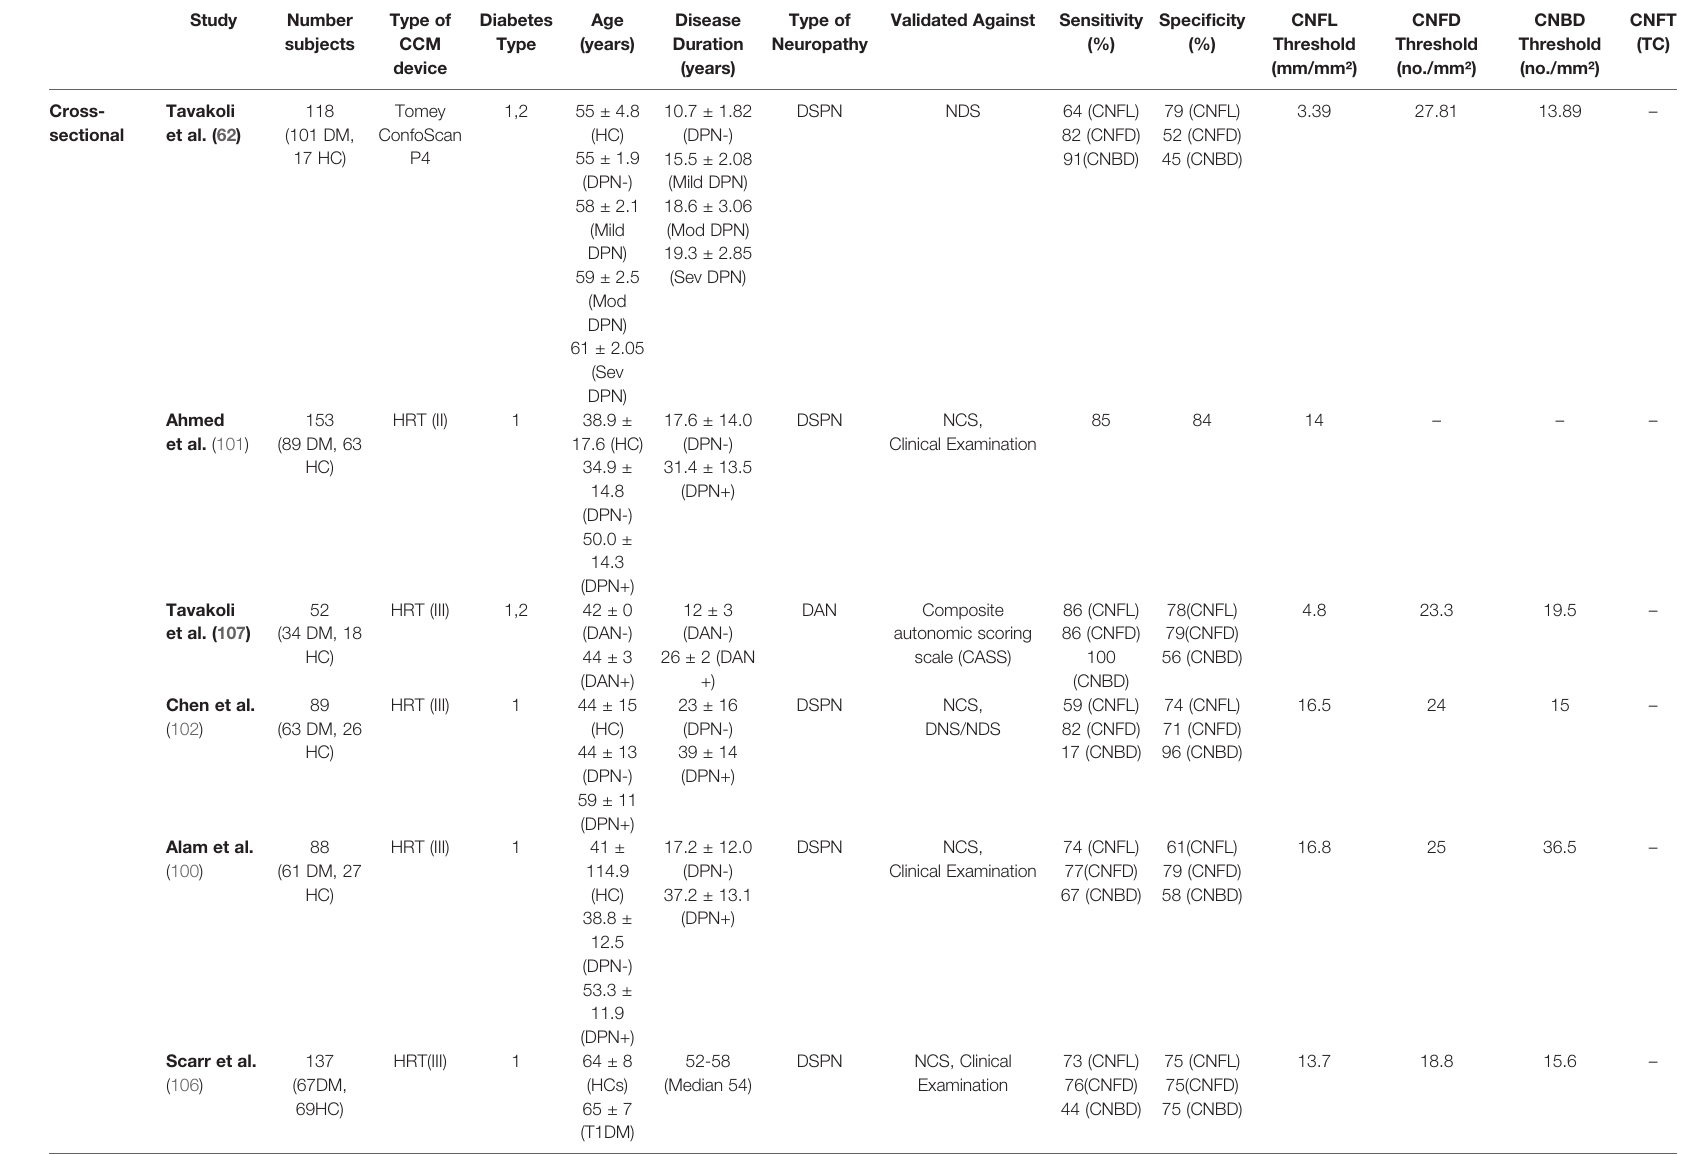
TABLE 5 | Summary of studies assessing the clinical utility of corneal nerve parameters for the diagnosis of clinical levels of diabetic neuropathy compared to chosen reference standards. Study